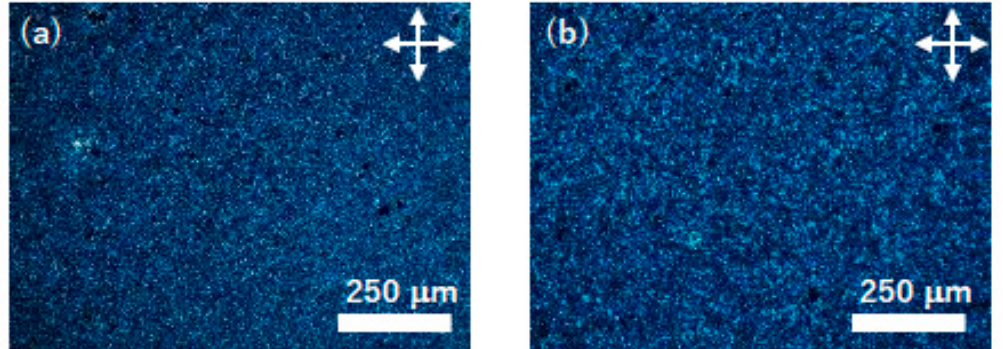
Figure 5. Polarizing optical micrographs of a thin films of compound ( S ) − 1 deposited on UV/O 3 --treated substrates ( a ) before and ( b ) after the ring-opening polymerization. The polymerization was carried out at 70 °C and the photographs were taken at 30 °C. White arrows indicate the optical axes of the polarizer and analyzer.